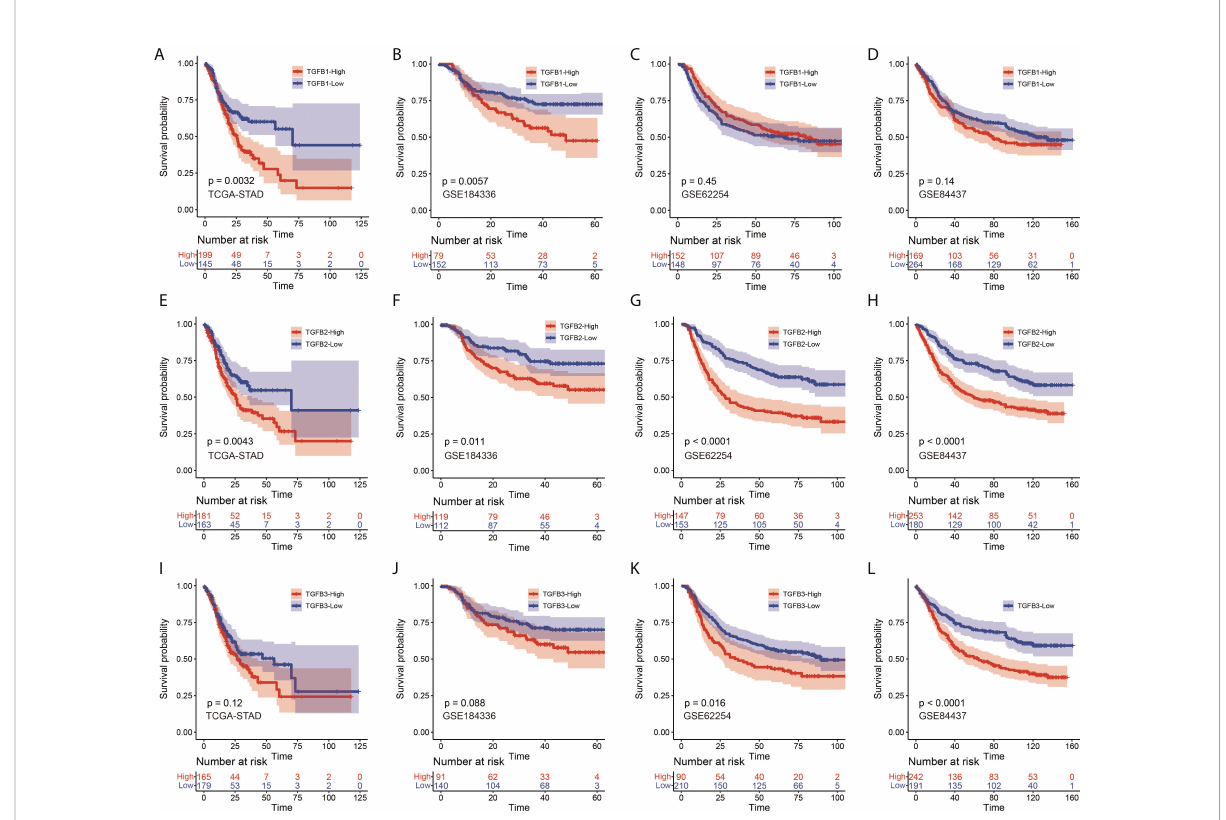
FIGURE 2 KM survival analysis of TGF b 1 (A – D), TGF b 2 (E – H) and TGF b 3 (I – L) in STAD, GSE184336, GSE84437 and GSE62254 data sets, respectively.